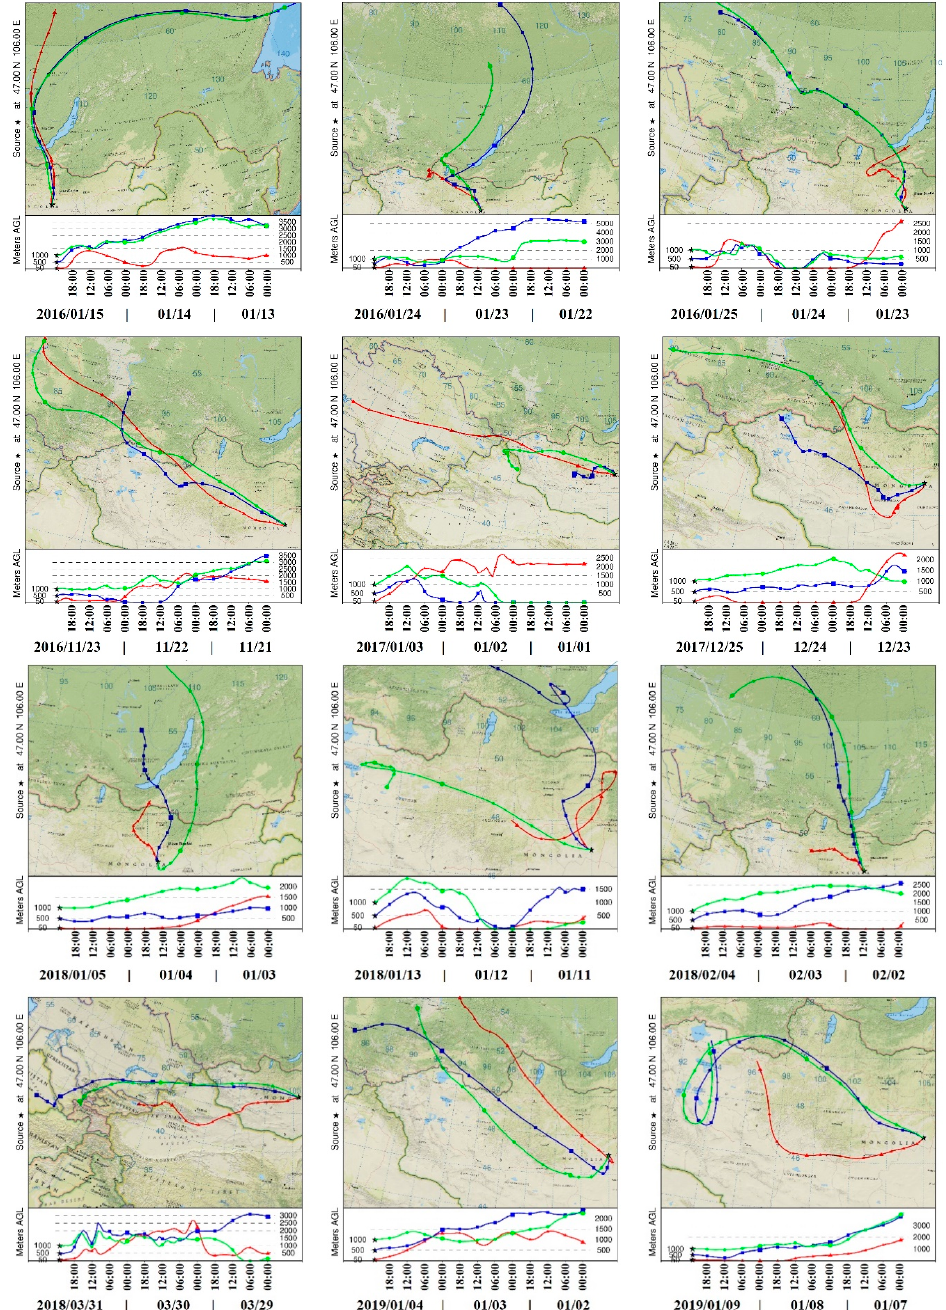
Figure 9. A 48 h backward trajectory analysis of heavily polluted days from 2016 to 2019.